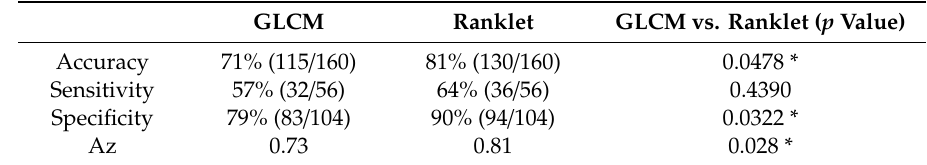
Table 1. Performance comparisons between gray level co-occurrence matrix (GLCM) and Ranklet features in classifying strokes